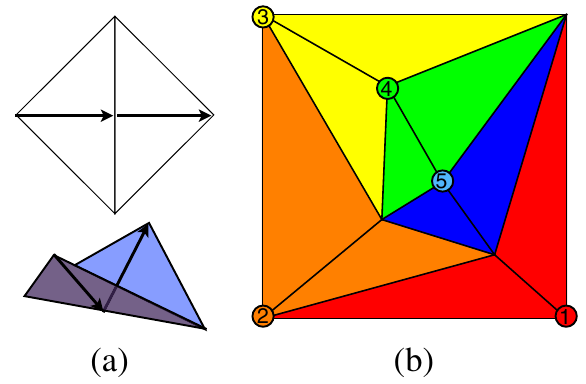
FIG. 10. (a) An illustration of the distance-maximization property of the unfolded state for a “ butterfly. ” (b) An H1 ¼ 4 . One possible reduction se- triangulated origami with V i quence is depicted, with butterflies and their associated boundary degree-3 vertices colored and labeled in order: (1) red, (2) orange, (3) yellow, (4) green, and ending on (5) the blue seed.